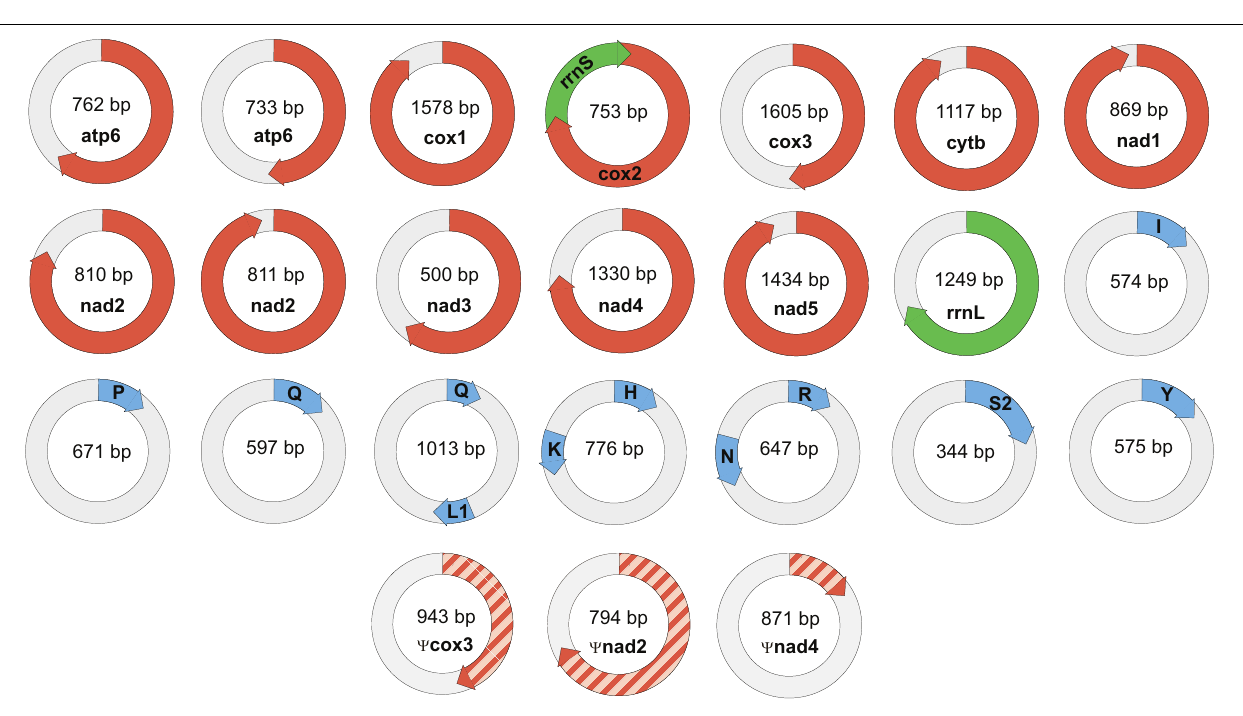
FIGURE 6 | Mini-circles coding mitochondrial genes in Dicyema sp. Lenght of each minicircle is marked in its center. Each minicircle has a coding region with gene name and transcription orientation, and a non-coding region (in light gray). Protein-coding genes marked in red, rRNA genes marked in green, and tRNA genes marked in blue. tRNA genes indicated by a one-letter amino acid